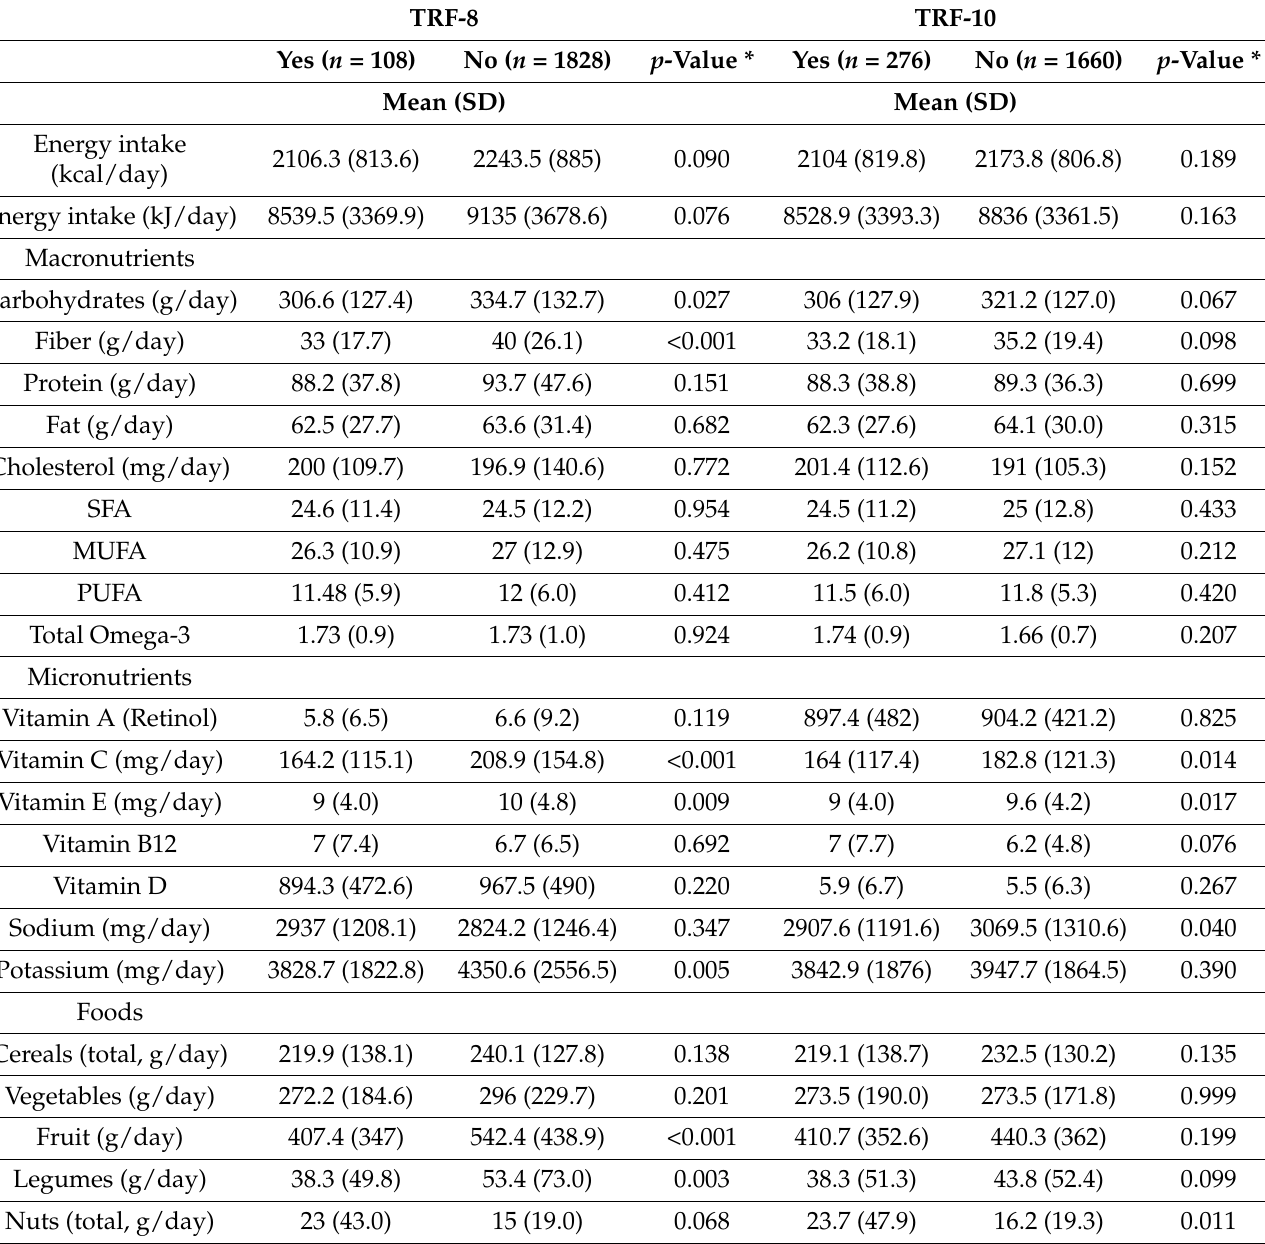
Table 2 shows micro- and macronutrients and major food groups consumption across time feeding groups in order to test whether there was any quantitative or qualitative dietary difference between groups. There was no different energy intake between either TRF-10 or TRF-8 groups and no TRF groups. In contrast, participants eating in a restricted window of time had significantly lower intake of vitamin C, E and consumed more nuts and dairy products than those with longer feeding time. Moreover, individuals belonging to the TRF-8 group also had a lower intake of fiber, potassium, fruit, legumes, and higher amounts of meat (total). Table 2. Mean (and standard deviation) of micro- and macronutrients and major food groups intake according to time- restricted feeding